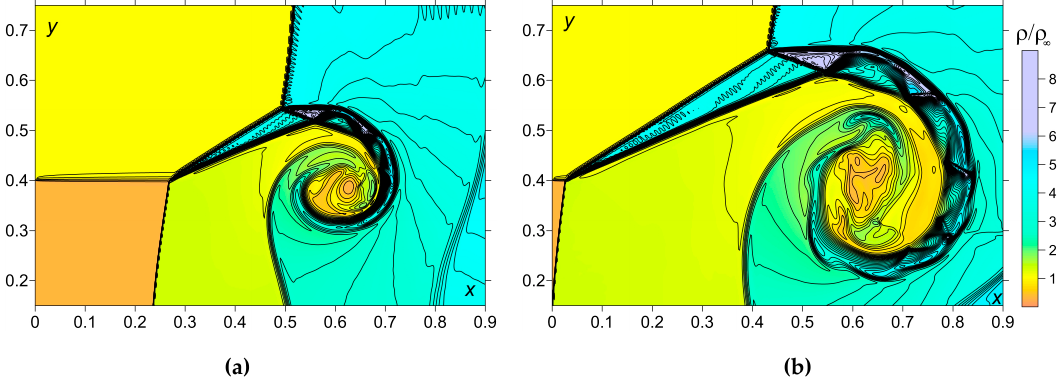
Figure 12. Dynamics of vortex-contact structure accompanying the formation of triple-shock configuration. Density (colors and isochors), M = 7, γ = 1.4, α ρ = 0. 3, enlarged: ( a ) dimensionless time t = 0.2; ( b ) t = 0.3.